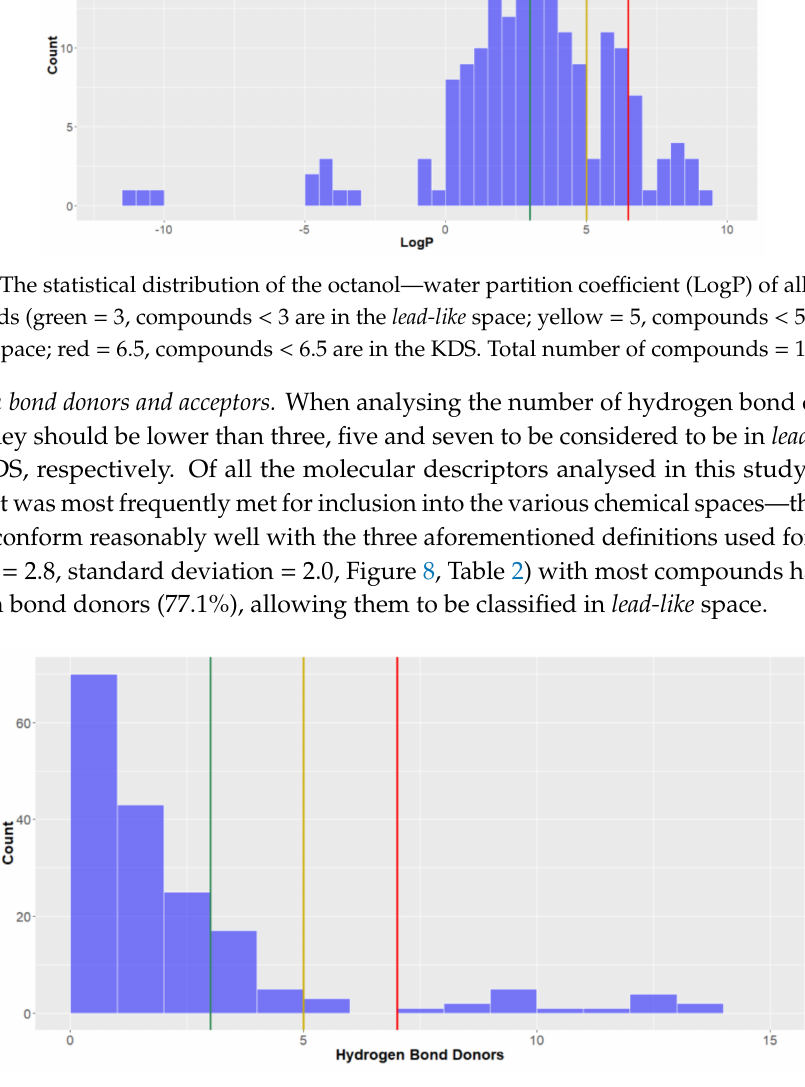
Figure 8. The statistical distribution of the hydrogen bond donors of all analysed compounds (green = 3, compounds < 3 are in the lead-like space; yellow = 5, compounds < 5 are in the drug-like space; red = 7, compounds < 7 are in the KDS. Total number of compounds =